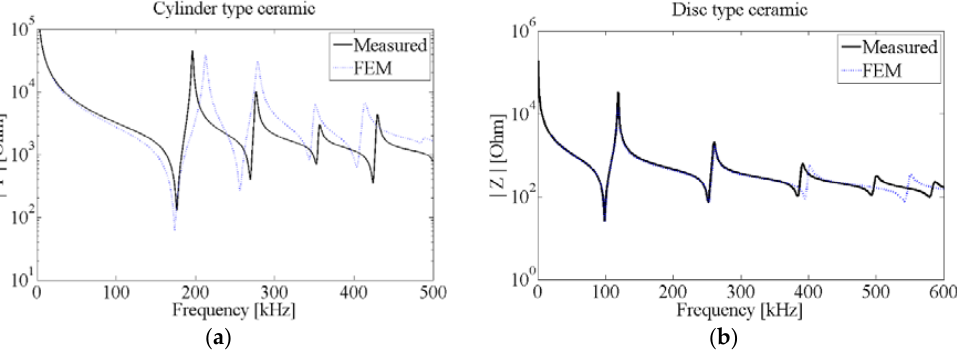
Figure 3. Impedance measurements and FEM simulations for PIC 255 cylinder ( a ) and disc ( b ).